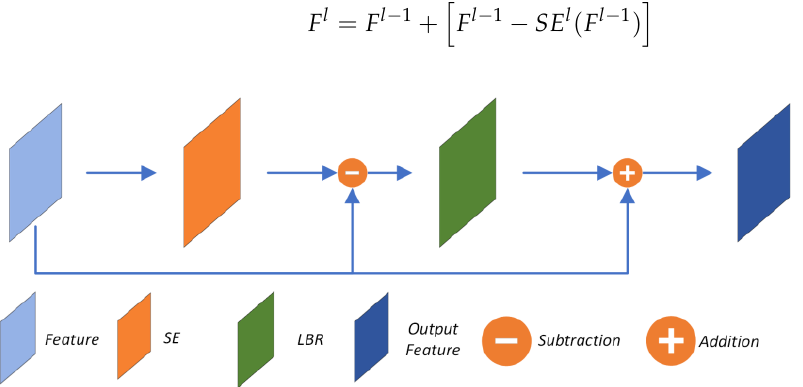
Figure 2. Network architecture of offset-attention, including features, self-attention, and LBR.